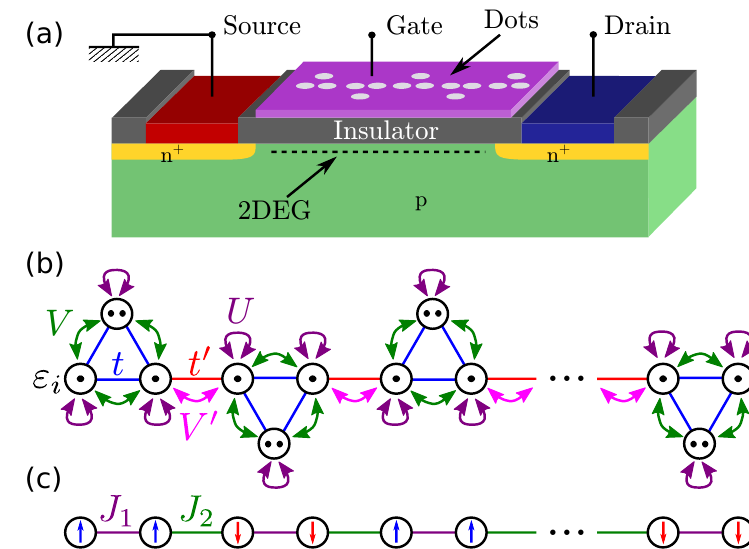
Figure 3. The artificial Haldane chain constructed from triple quantum dot molecules. ( a ) a schematic view of the system; ( b ) the parameters of the Hubbard-like model. The circles denote the quantum dots (QDs) and the black dots denote the electrons. The lines and arrows symbolize the single-particle hoppings and interaction terms, respectively; ( c ) the parameters of the spin-1/2 Heisenberg